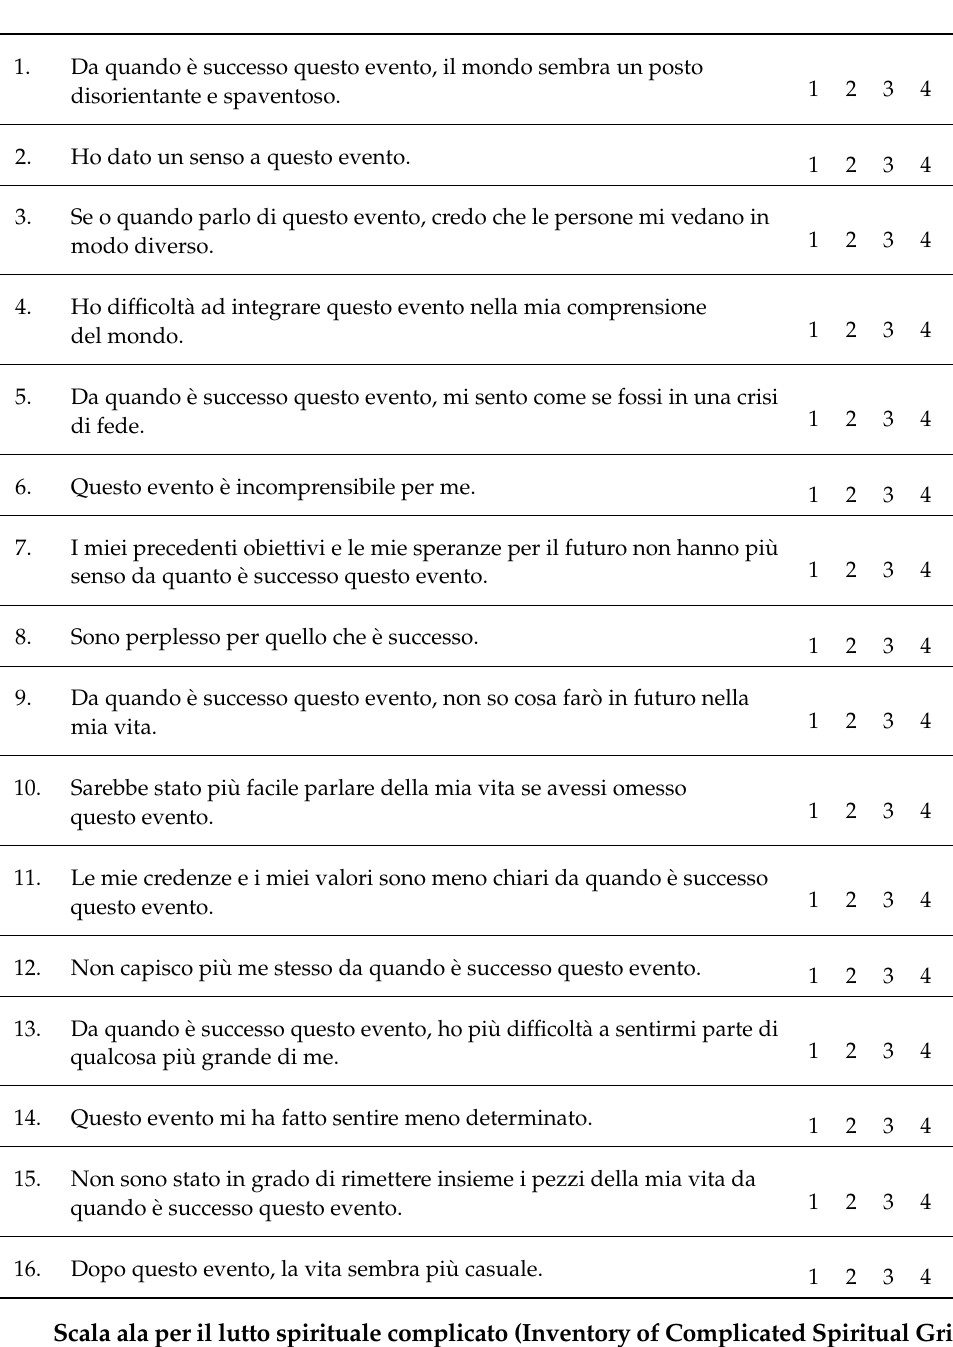
quando è successo questo evento. Dopo questo evento, la vita sembra pi ù casuale. Scala ala per il lutto spirituale complicato (Inventory of Complicated Spiritual Grief) Gentile partecipante, adesso le chiediamo di leggere attentamente le seguenti